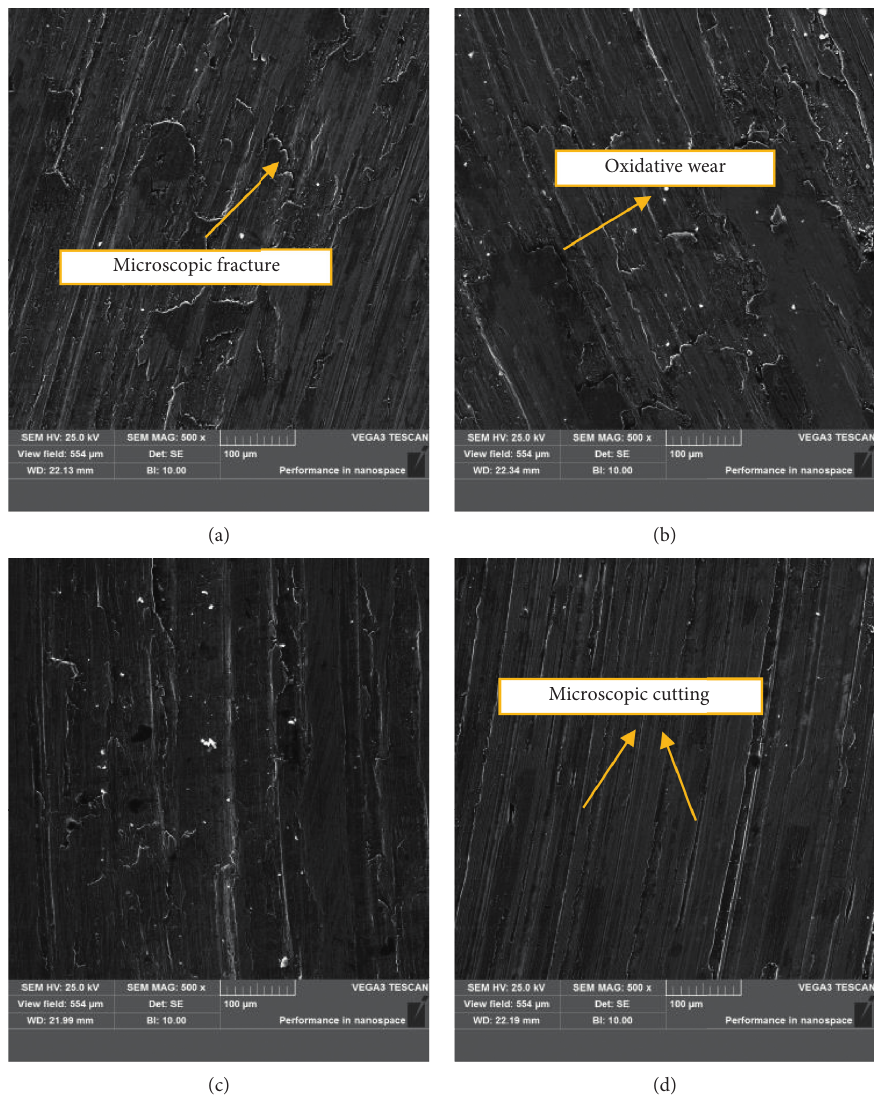
Figure 8: SEM images of wear scar on different process surfaces (500x): (a) UT, (b) HT, (c) DCT, and (d)